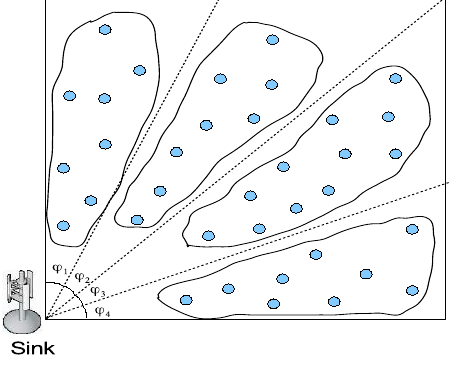
Figure 2. An example of sink position-based